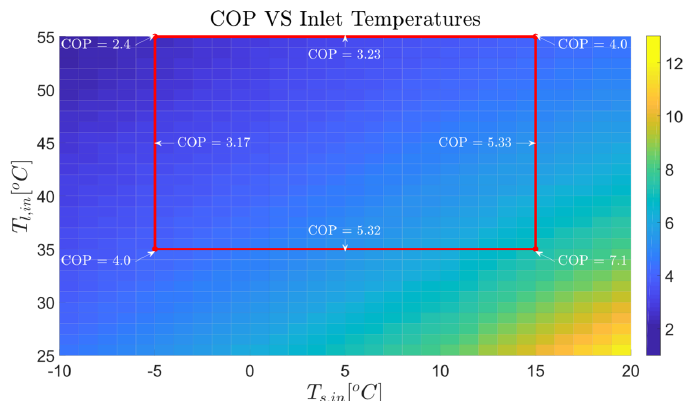
Figure 4. Fluid inlet temperatures versus the COP of the Vitocal 300-G heat pump, manufactured by Viessmann. The red rectangle indicates the temperatures limits between which data is specified by the manufacturer [20].